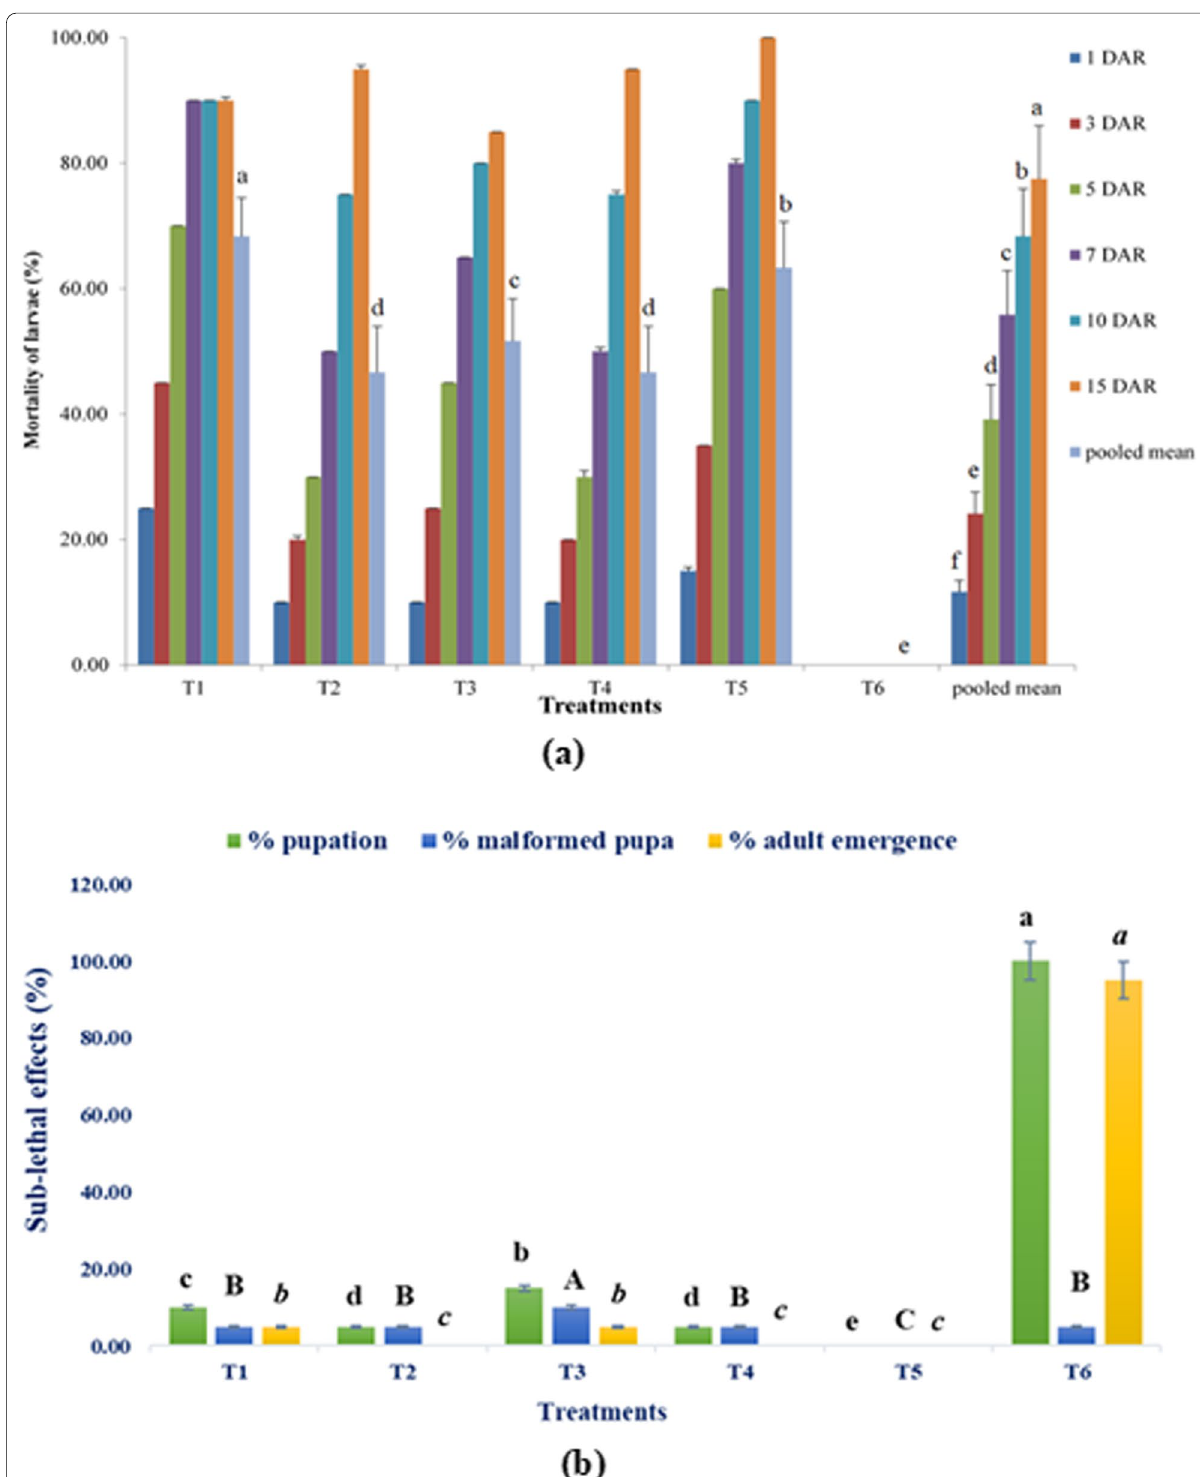
Fig. 6 Efficacy of endophytically colonized tomato plants by Beauveria bassiana isolate UHSB-END1 on Spodoptera litura after 40 dpi a Larval mortality at different Days After Release (DAR) of 2nd S. litura larvae. Data were mean vitro assay. Mortality data are subjected to one-way ANOVA, and means are compared by DMRT. (T1—seed treatment, T2—seedling root dip, T3— soil drenching, T4—foliar spray, T5—combination,